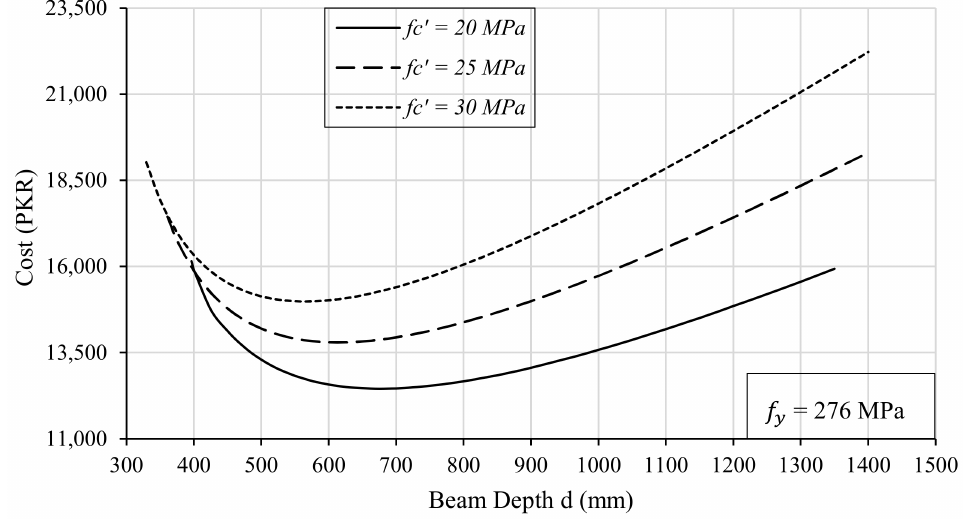
Figure 8. Effect of Compressive Strength of Concrete on Beam Depth